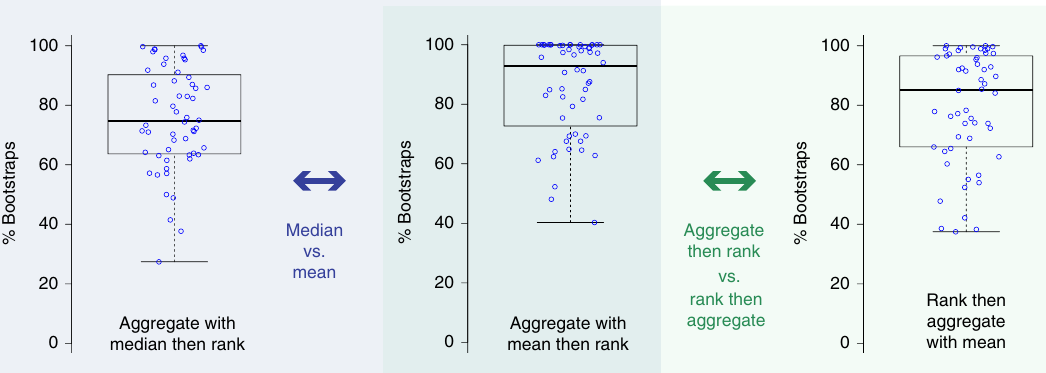
Fig. 3 The ranking scheme is a deciding factor for the ranking robustness. The center line in the boxplots shows the median, the lower, and upper border of the box represent the fi rst and third quartile. The whiskers extend to the lowest value still within 1.5 interquartile range (IQR) of the fi rst quartile, and the highest value still within 1.5 IQR of the third quartile. According to bootstrapping experiments with 2015 segmentation challenge data, single-metric based rankings (those shown here are for the DSC) are signi fi cantly more robust when the mean rather than the median is used for aggregation (left) and when the ranking is performed after aggregation rather than before (right). One data point represents the robustness of one task, quanti fi ed by the percentage of simulations in bootstrapping experiments in which the winner remains the winner